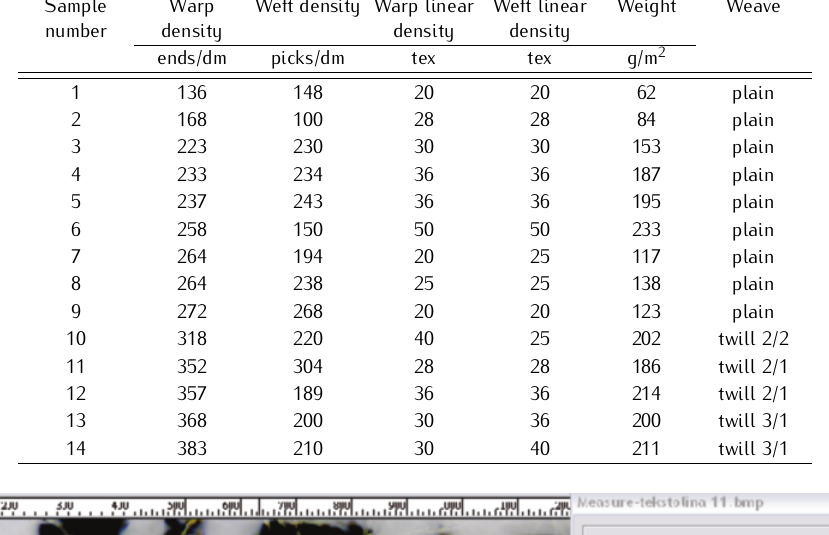
Table 1. Structural characteristics of the investigated samples.